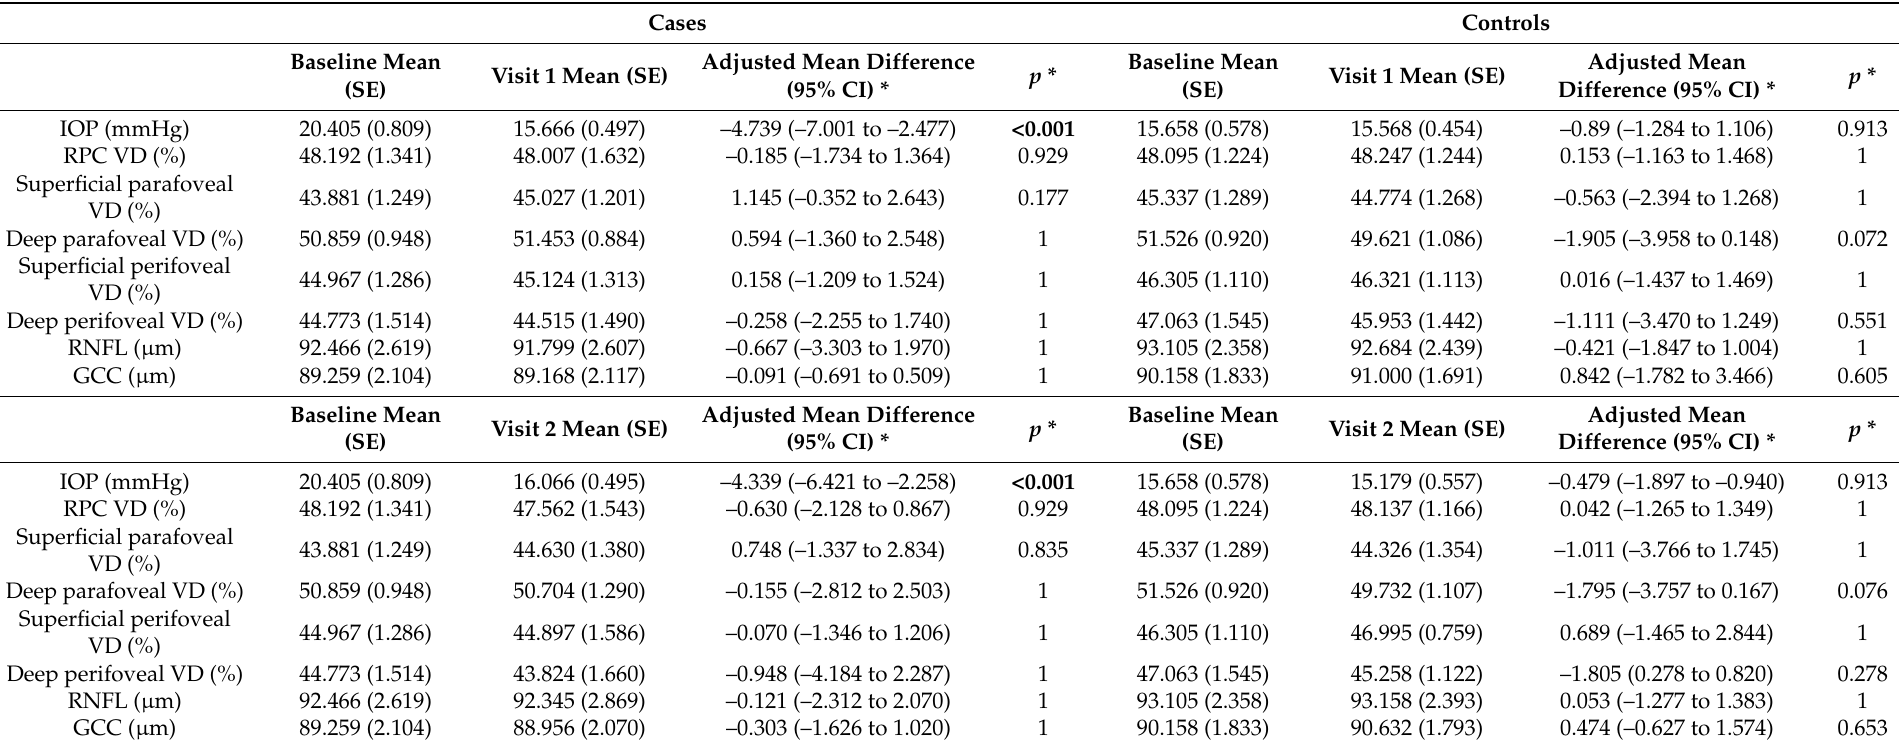
Table 2. Comparison of the optical coherence tomography angiography parameters at baseline and follow-up visits in the cases and